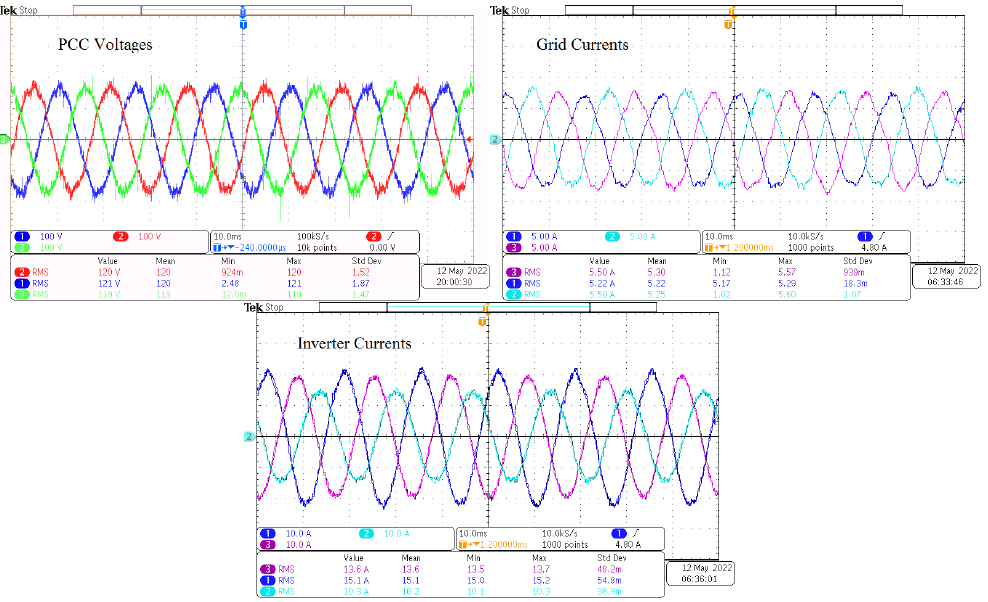
Figure 14. Experimental results at P = 2 kW, Q = 0